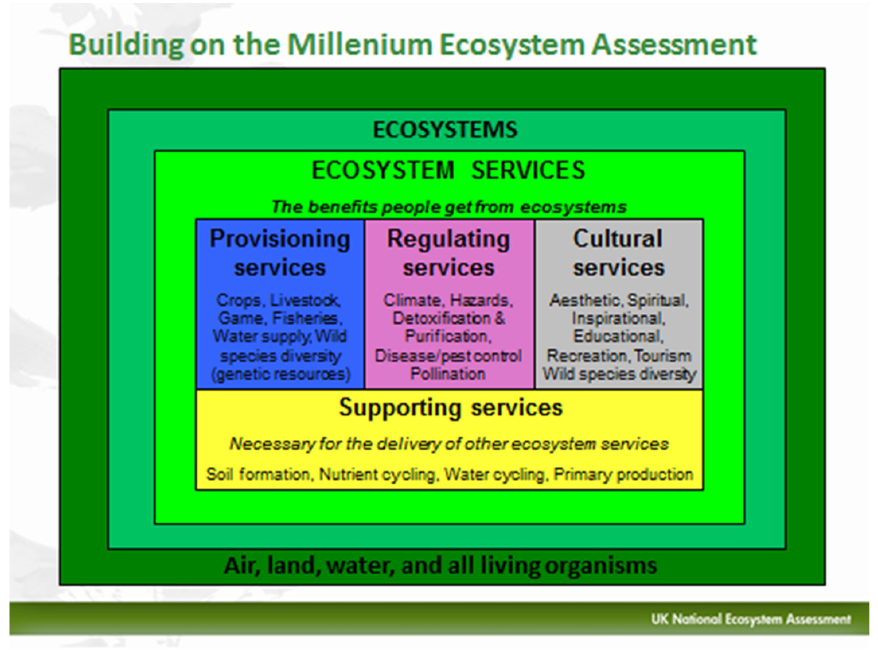
Figure 20. Incorporation of Ecosystem services terminology within the UK NEA. Source: UK National Ecosystem Assessment 2011